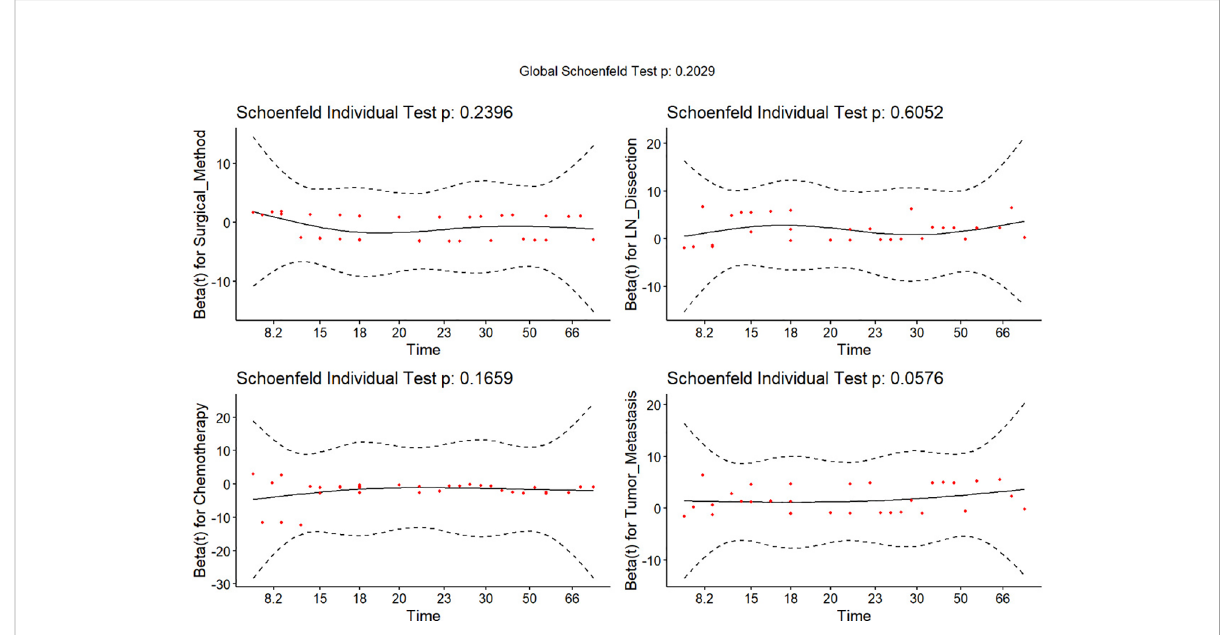
FIGURE 2 Schoenfeld residual plots to test whether relevant factors match an equal-proportional-hazards model: There was no signi fi cant correlation between the candidate variables and time (P>0.05), so the risk ratio between all these variables and outcome was fi xed.